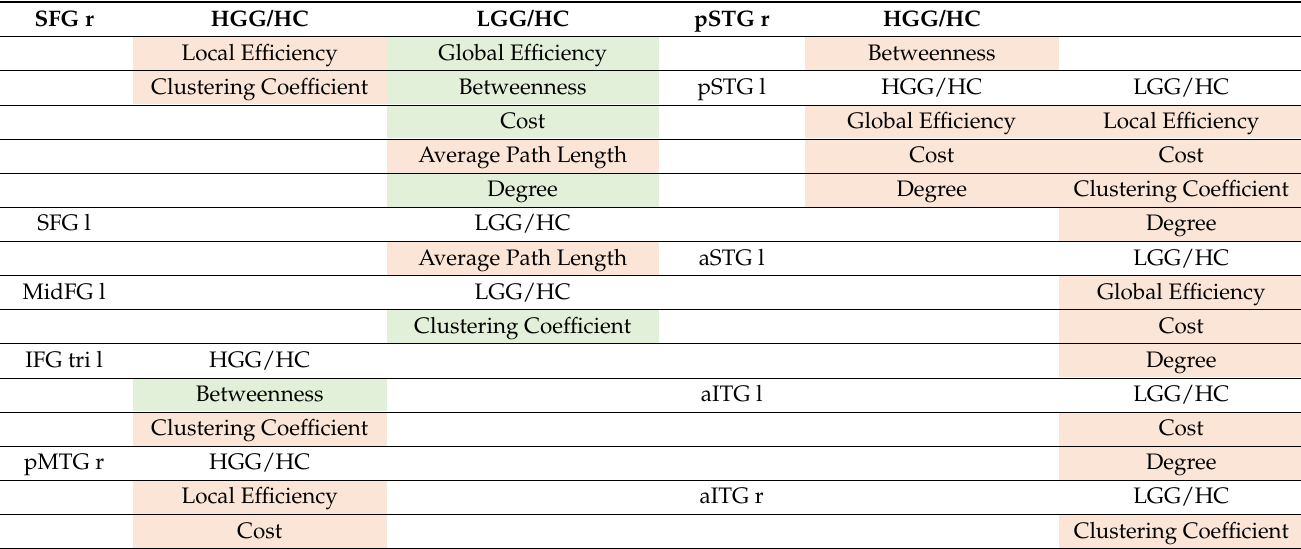
Table 4. Increased (green) or decreased (red) mean values of significant graph